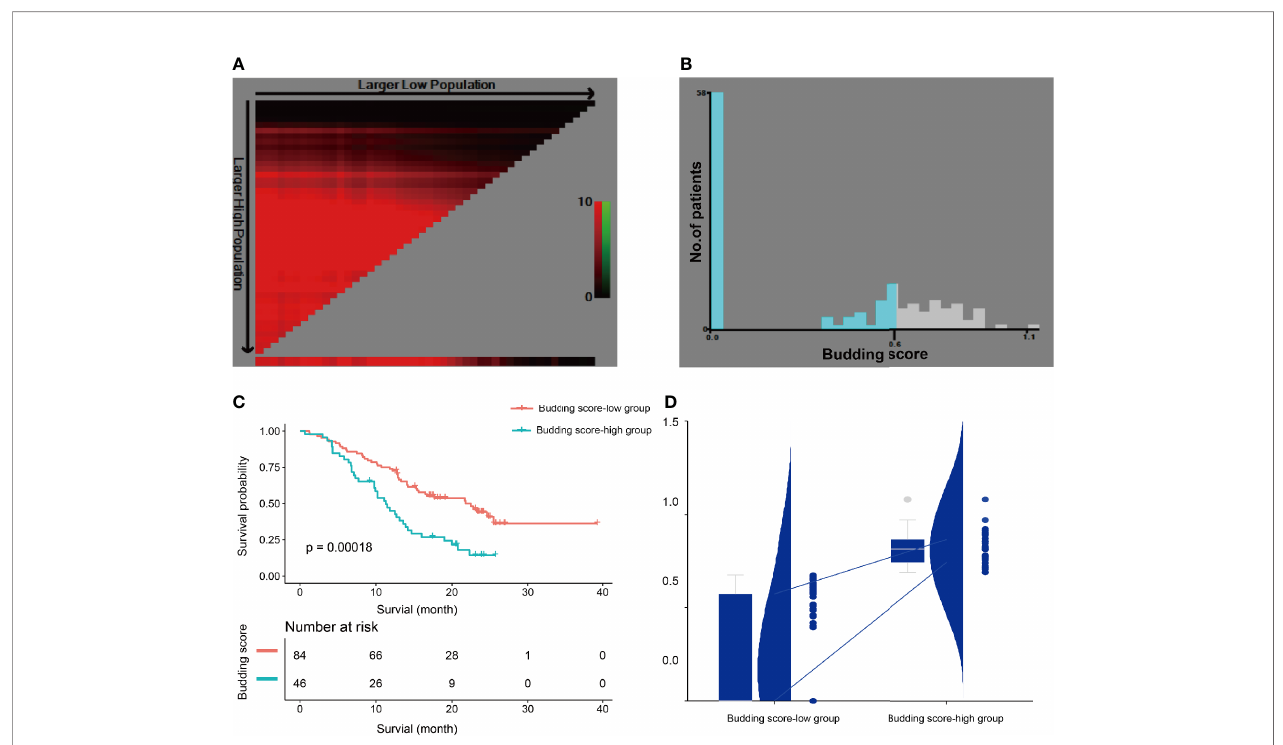
FIGURE 3 | X-tile analysis of the survival data in patients with pancreatic ductal adenocarcinoma. (A, B) The optimal cutoff level of the tumor budding (TB) score is 0.62, which was determined by X-tile and used to de fi ne the TB score-low and TB score-high groups. (C) The Kaplan – Meier curve and log-rank test suggest that patients in the TB score-low group survived signi fi cantly longer than did those in the TB score-high group. (D) TB scores in the TB score-low and TB score-high groups. The chart includes a box plot, density plot, and a dot plot. The 25th and 75th percentiles are shown as connecting lines between the groups.